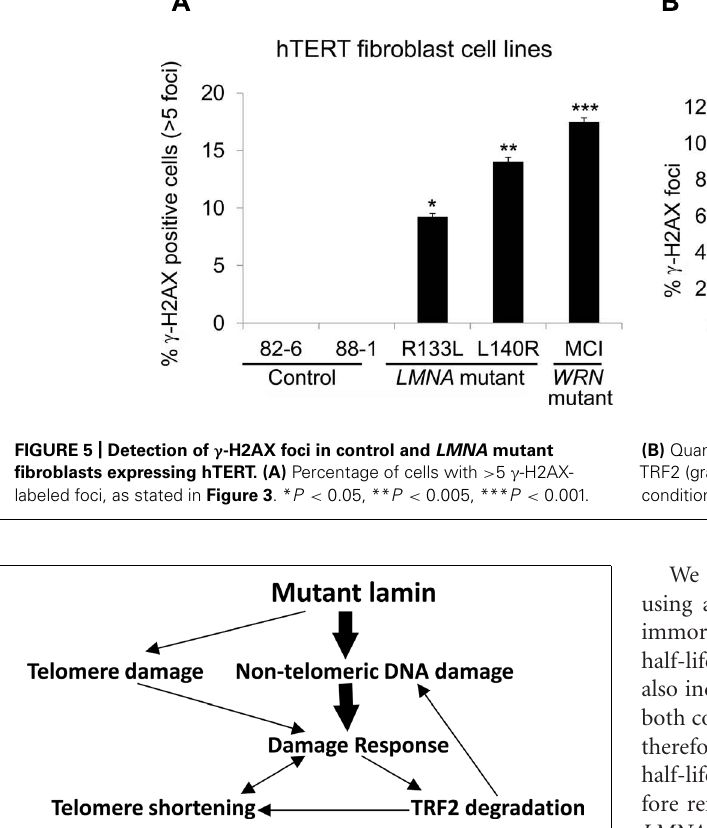
FIGURE 6 | Potential mechanisms ofTRF2 degradation and telomere shortening in LMNA mutantAWS cells. Our data support the hypothesis that in young passage cells, though mutant lamin may initiate some DNA damage to the telomeres, the bulk of the DNA damage accumulates within non-telomeric DNA (bold arrows).The latter may be largely responsible for the initiation of a DNA damage response, followed byTRF2 degradation and destabilization of the telomere–shelterin complex.These alterations in turn cause rapid telomere attrition (Oh etal., 2003) and replicative senescence in these cells. Depletion ofTRF2 protein along with insufficient DNA damage repair may also increase the overall levels of genomic DNA damage via a positive feedback loop (Mao etal., 2007). In senescent LMNA mutant cells, all the pathways may be